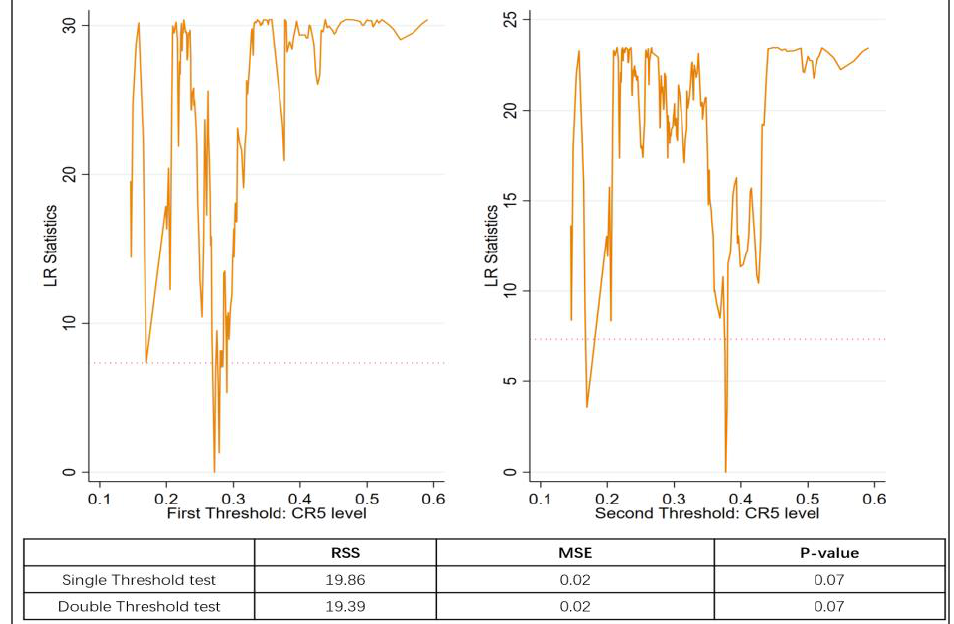
Figure 4. Threshold test for bank competition level.